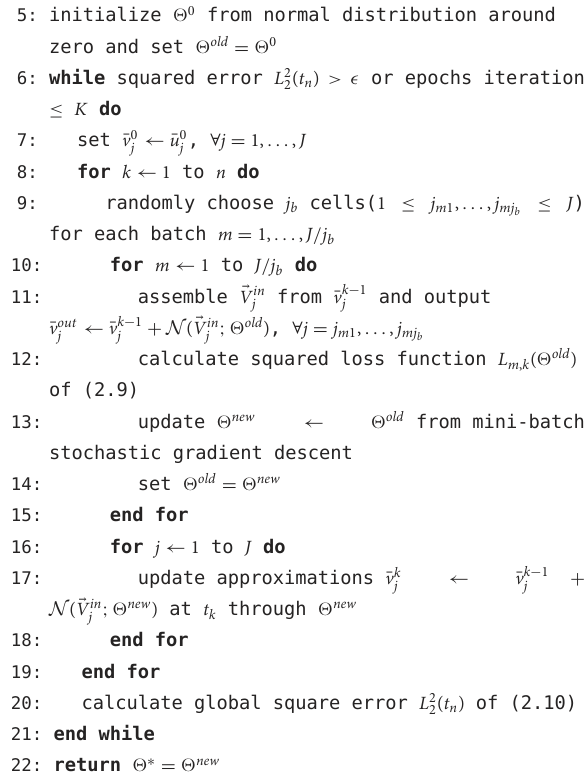
parameter 2 ∗ successfully trained, the CANN method is well 2 ∗ ) available, the trained CANN defined. Now, with N ( V in j ; E method can be implemented as an explicit one-step time discretization method as follows: starting from cell averages of a